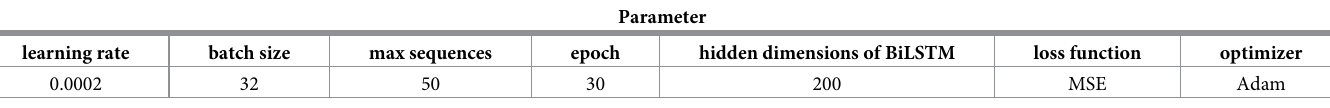
Table 3. The optimal parameter settings